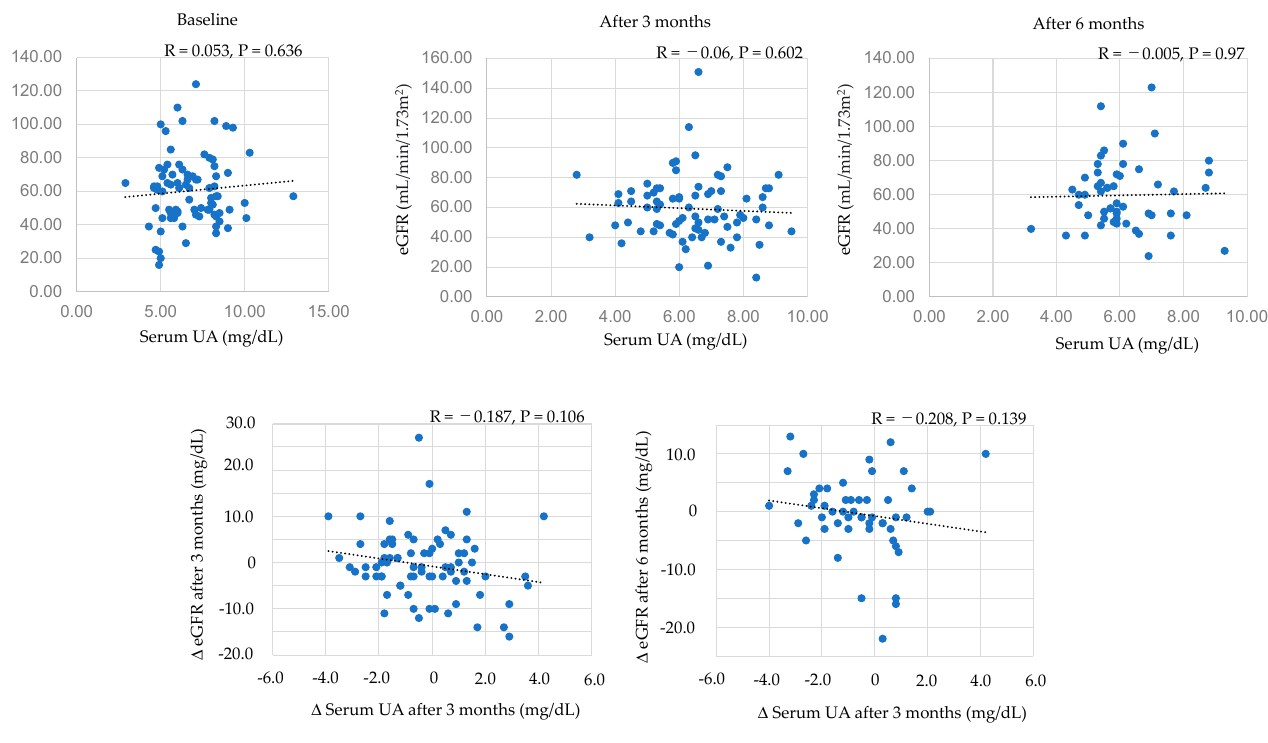
Figure 7. Correlations between serum UA and eGFR.